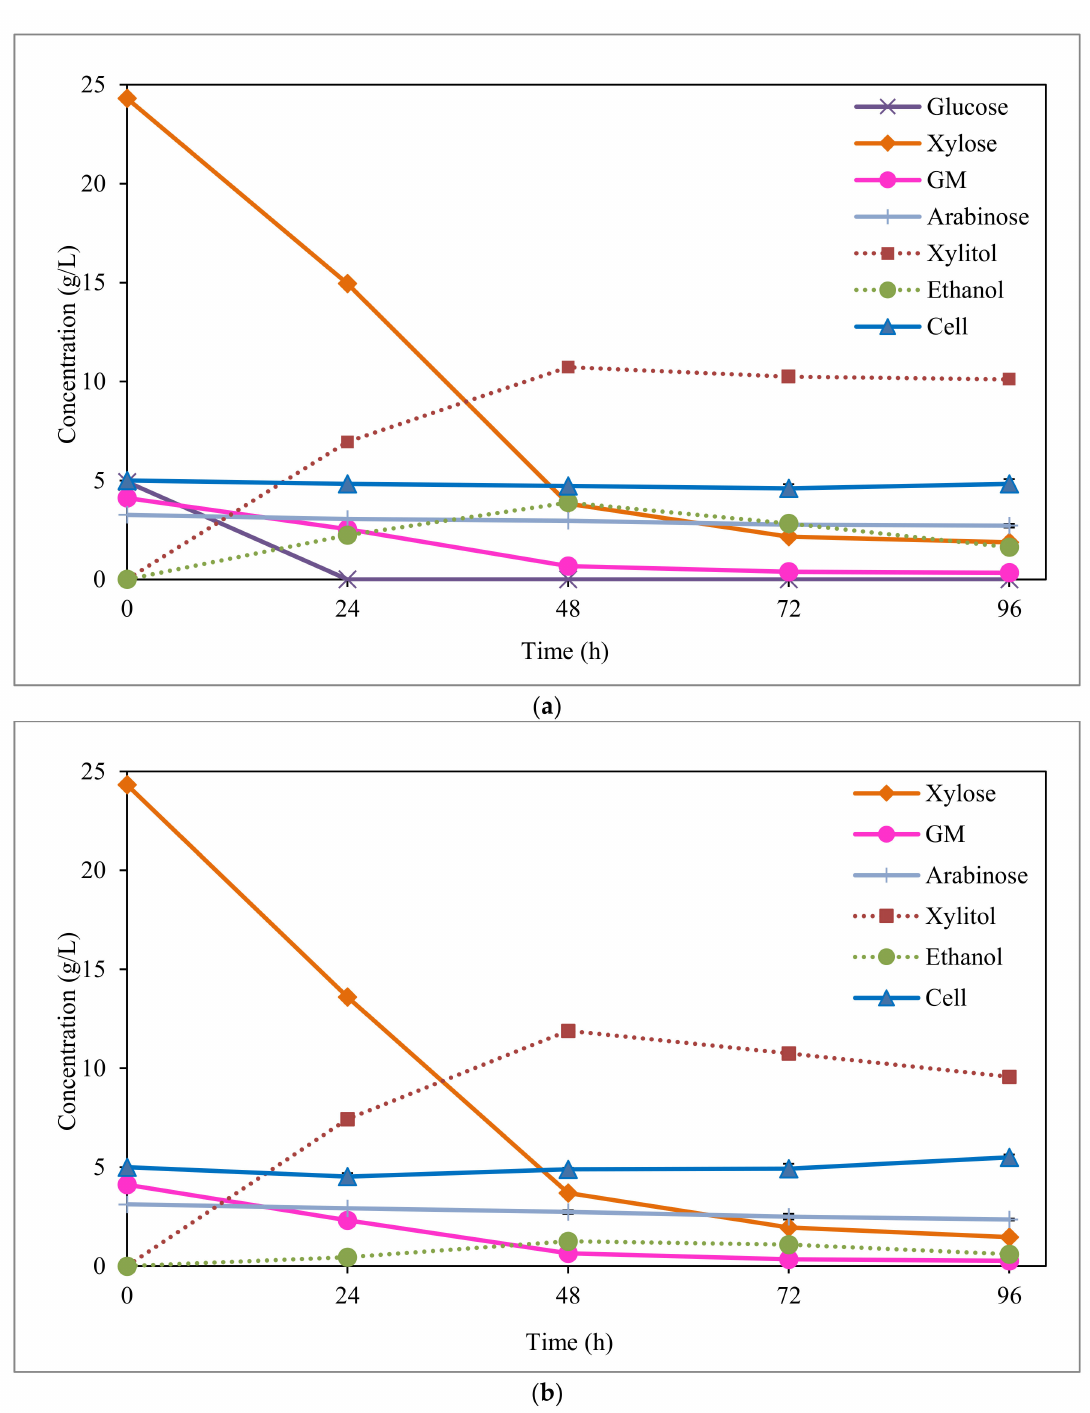
Figure 2. Fermentation of SM1; and ( a ) SM2; ( b ) synthetic media by C. boidinii . GM: sum of galactose and mannose. SM1: synthetic medium with the same sugars concentration contained in acid hydrolysate before detoxification. SM2: same composition of SM1 but without